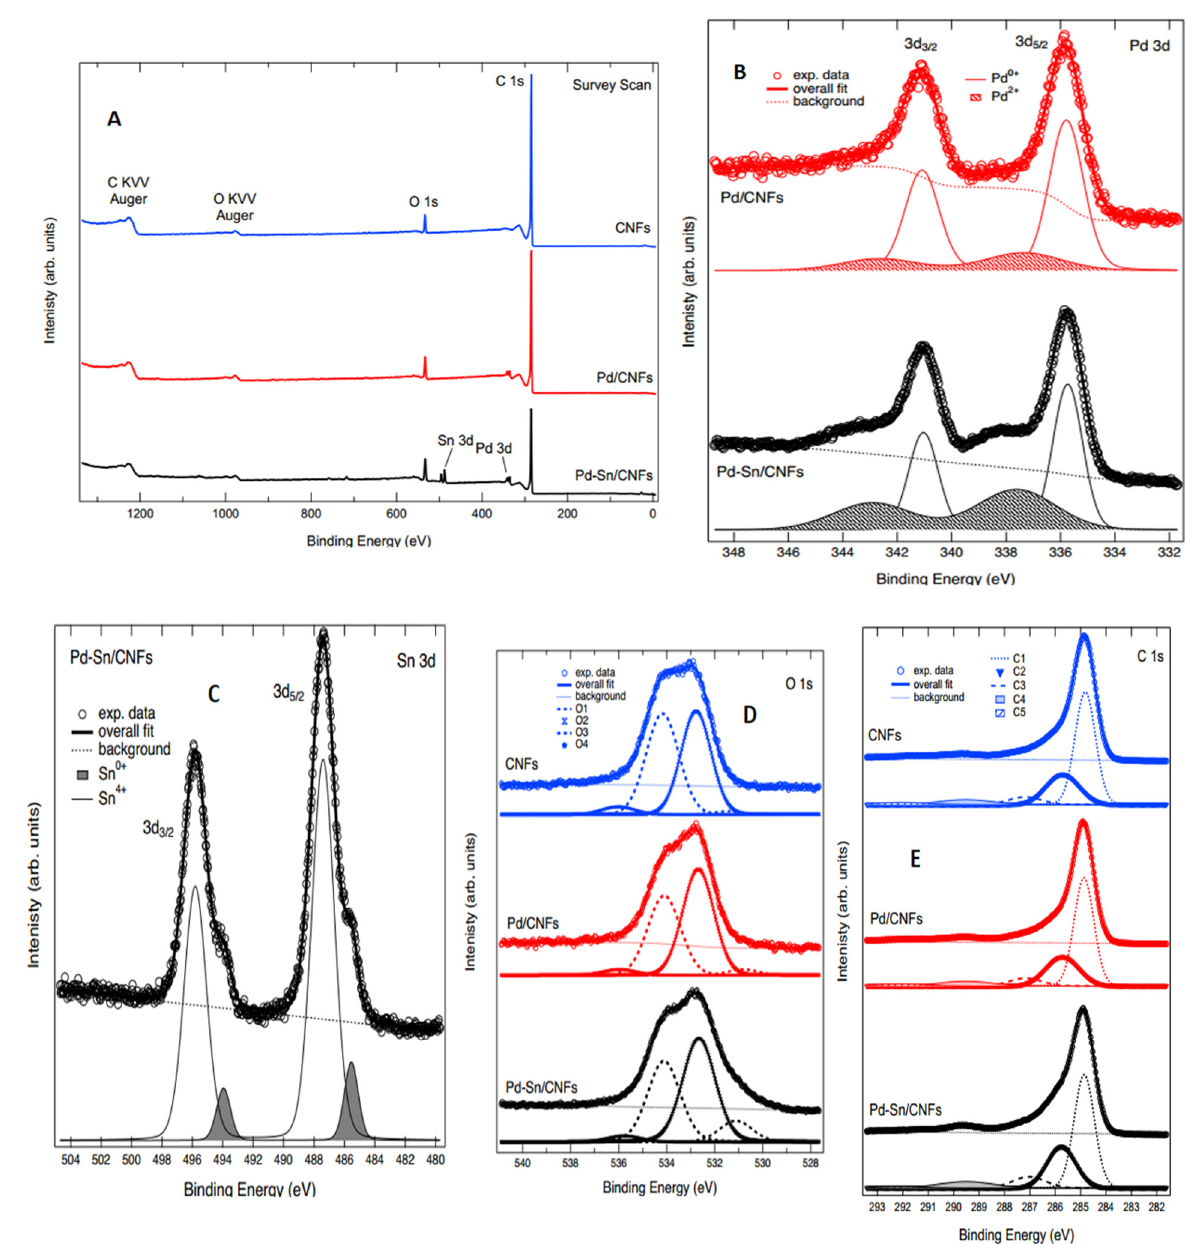
Figure 4. XPS spectra ( A ) survey spectra for ( B ) Pd 3d for Pd/CNFs and Pd-Sn/CNFs electro-catalysts, ( C ) Sn 3d for Pd-Sn/CNFs electro-catalyst, ( D ) O 1s for CNFs, Pd/CNFs and Pd-Sn/CNFs electro-catalysts, ( E ) C 1s for CNFs, Pd/CNFs and Pd-Sn/CNFs electro-catalysts.